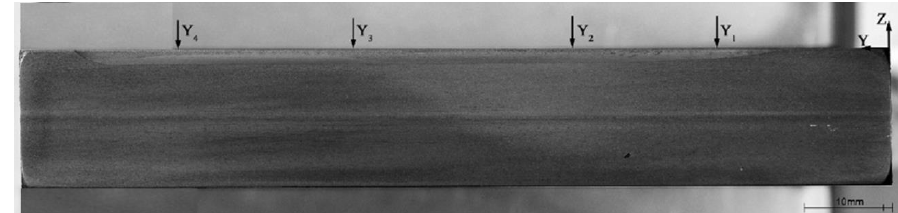
Figure 3. Sample cross-section in YZ symmetry plane with marked hardness measurement positions.